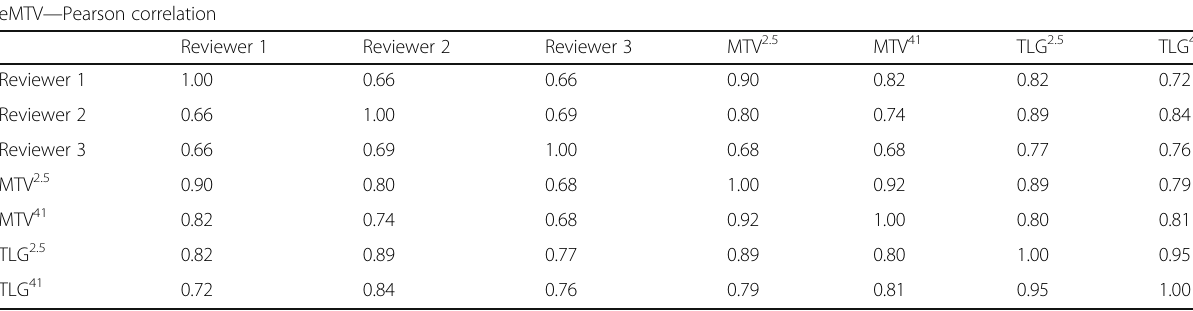
Table 3 Pearson correlation between visually assessed eMTV and semi-automated measurements eMTV — Pearson